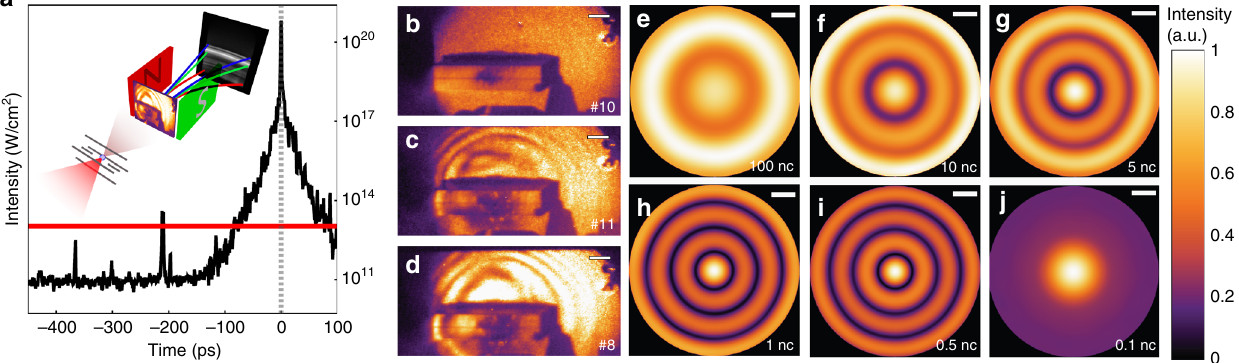
Fig. 1 Pre-plasma formation. a Autocorrelation curve of the PHELIX laser pulse scaled to the maximum on-target intensity 7 × 10 20 W/cm 2 . The horizontal line marks a typical value of plasma formation intensity for plastic. The inset shows the schematic experimental setup including the relevant diagnostics. Experimental recorded diffraction patterns at the scatter screen in front of the magnetic spectrometer for the case, b no target, c solid sphere, d hollow sphere are shown. The scale bar corresponds to 2 cm. e – j Simulated diffraction patterns for a variety of peak electron densities n m in units of critical density n c and corresponding plasma extension. The scale bar corresponds to 2